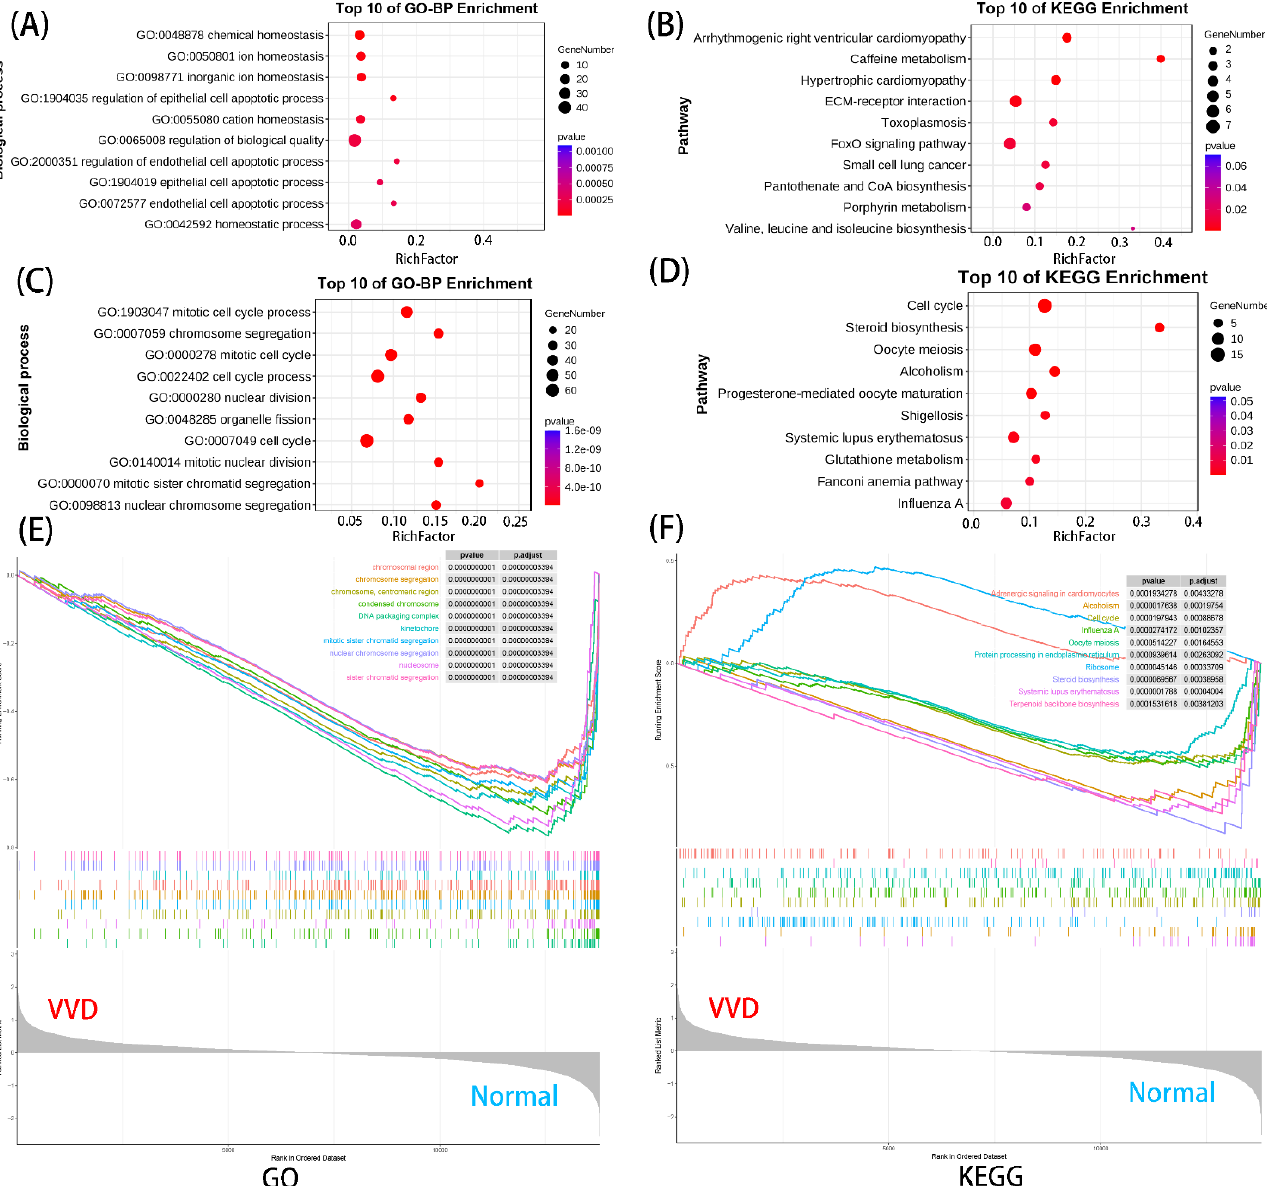
Figure 2. Functional enrichment analysis of the upregulated and downregulated DEmRNAs: ( A , B ) the top 10 GO-BP and KEGG enrichment analysis of upregulated DEmRNAs; ( C , D ) the top 10 GO-BP and KEGG enrichment analysis of downregulated DEmRNAs; ( E , F ) GSEA enrichment analysis of mRNAs.